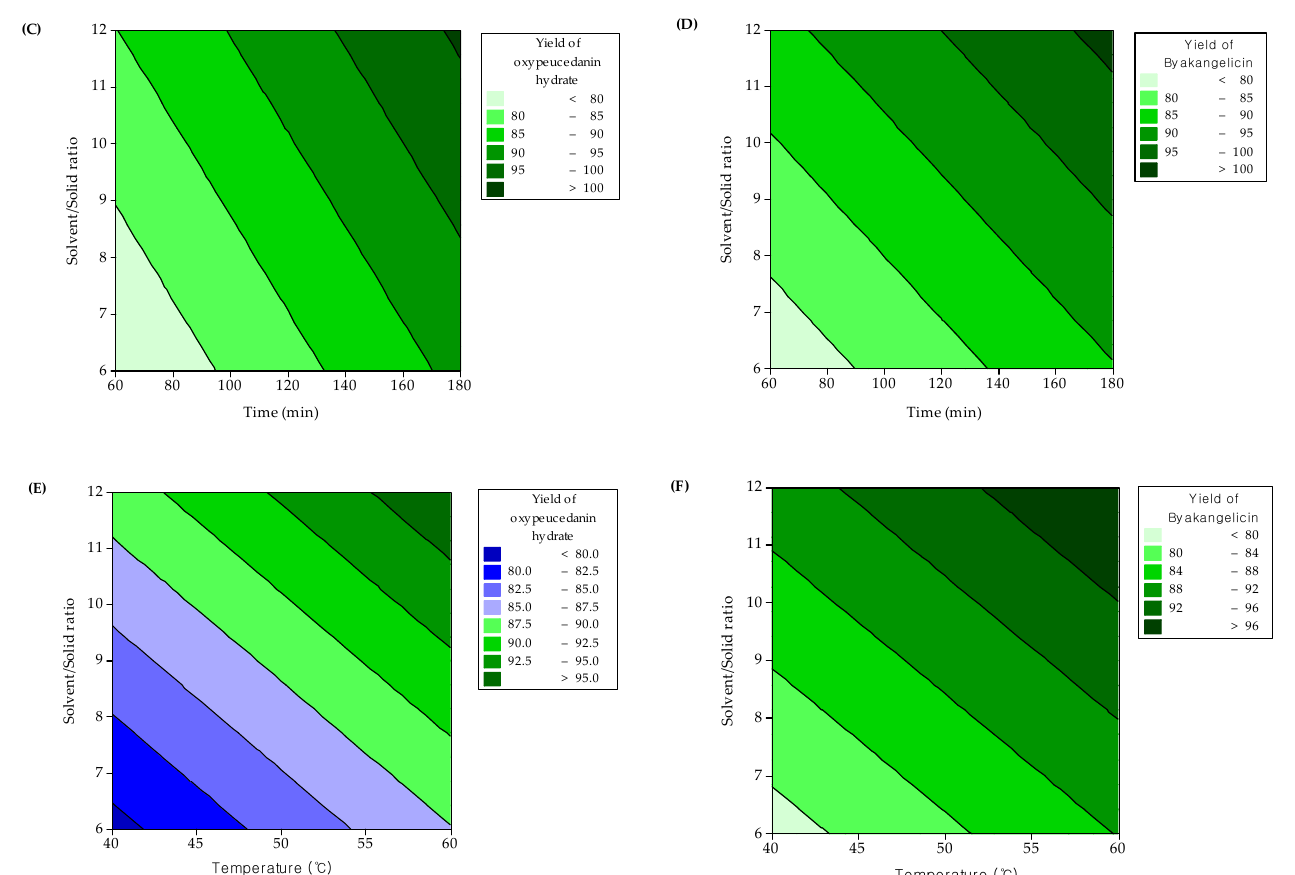
Figure 6. Contour plots of extraction yields of oxypeucedanin hydrate and byakangelicin versus variables. ( A ) effect of temperature and time on extraction yield of oxypeucedanin hydrate, ( B ) effect of temperature and time on extraction yield of byakangelicin, ( C ) effect of solvent/solid ratio and time on extraction yield of oxypeucedanin hydrate, ( D ) effect of solvent/solid ratio and time on extraction yield of byakangelicin, ( E ) effect of solvent/solid ratio and temperature on extraction yield of oxypeucedanin hydrate and ( F ) effect of solvent/solid ratio and temperature on extraction yield of byakangelicin.